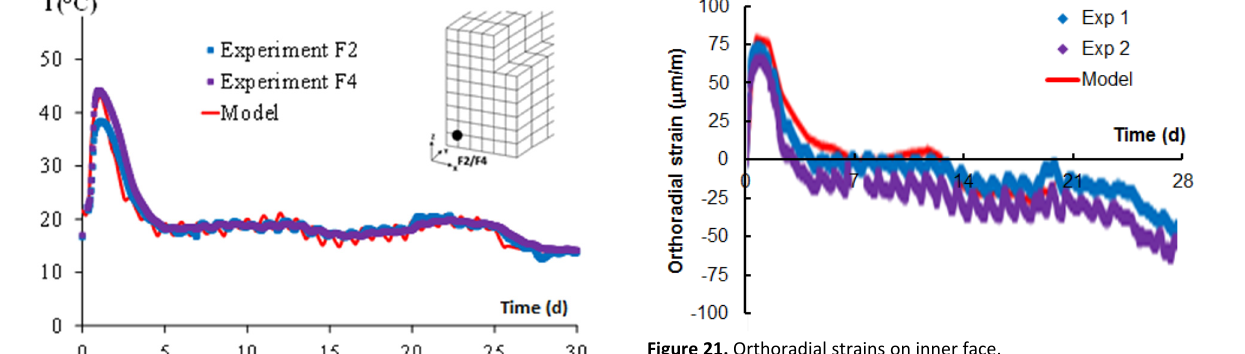
Figure 21. Orthoradial strains on inner face.